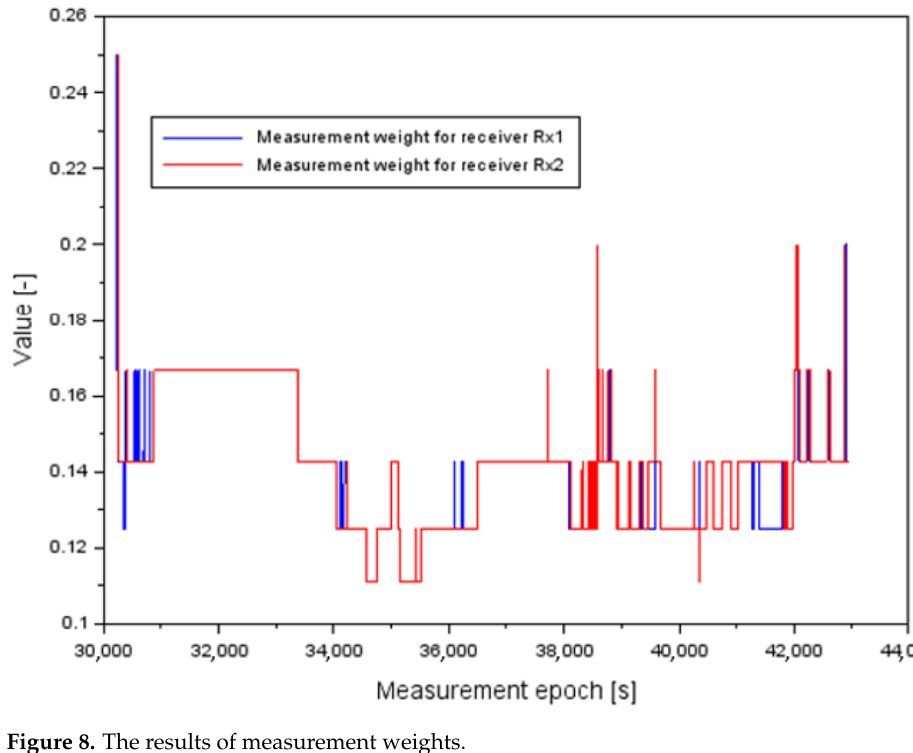
Figure 8. The results of measurement weights.